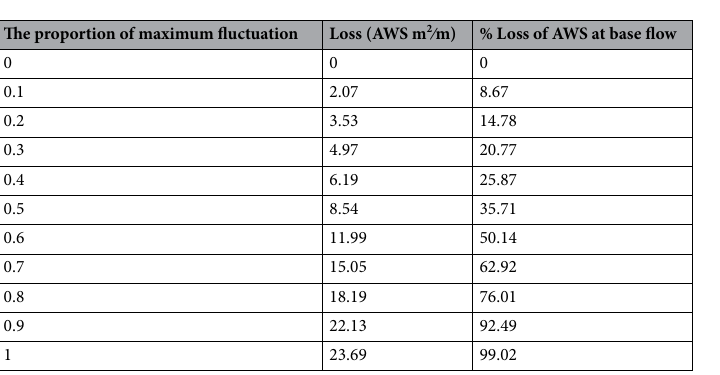
Table 1. Area weighted suitability (AWS) loss with flow fluctuations around a base flow of 536.112 cubic meter per second for May.